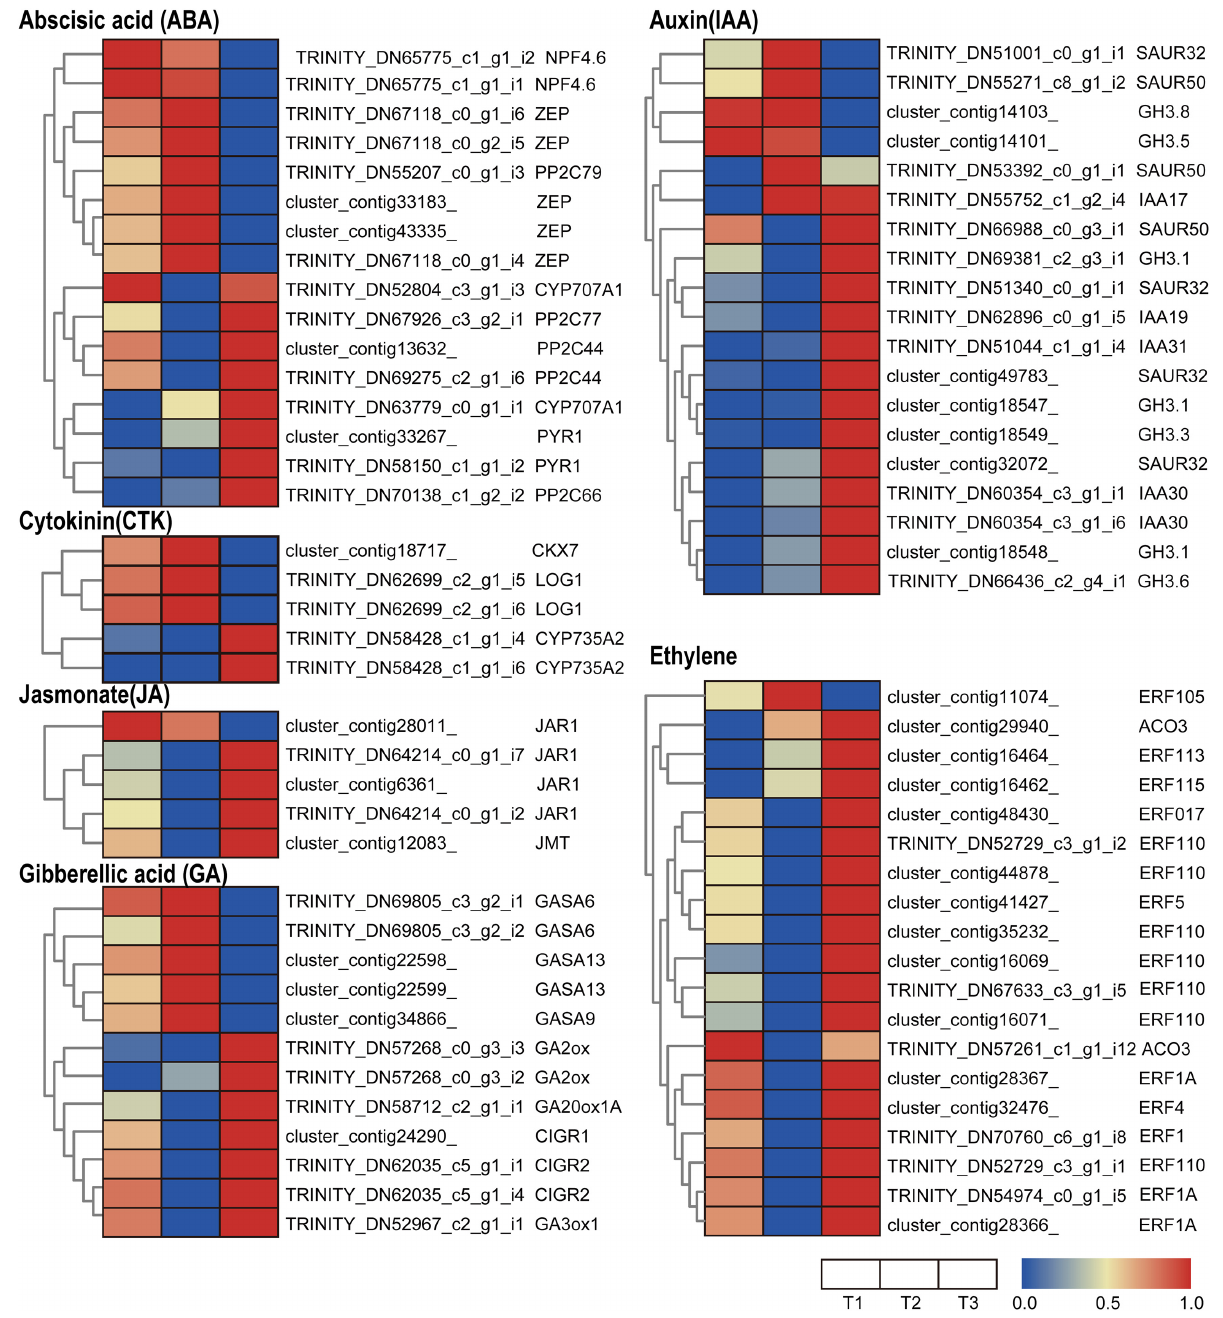
Frontiers in Plant Science |